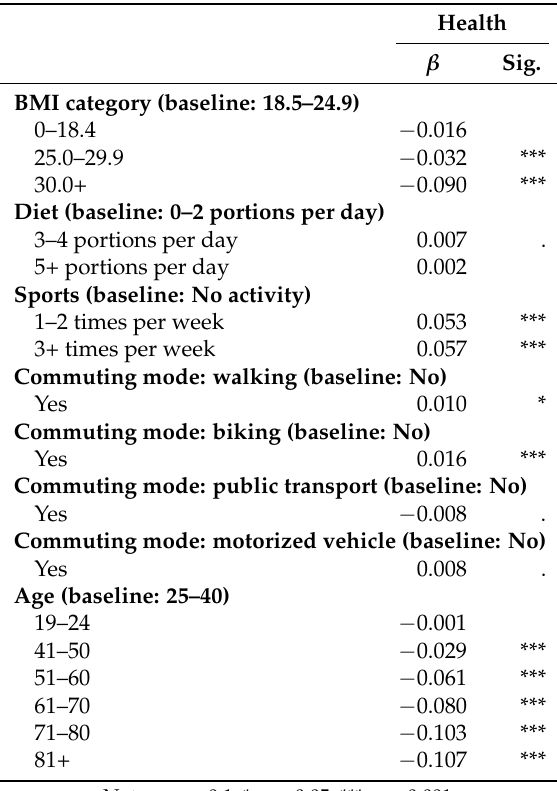
Table 6. Results for the regression model for health (Equation